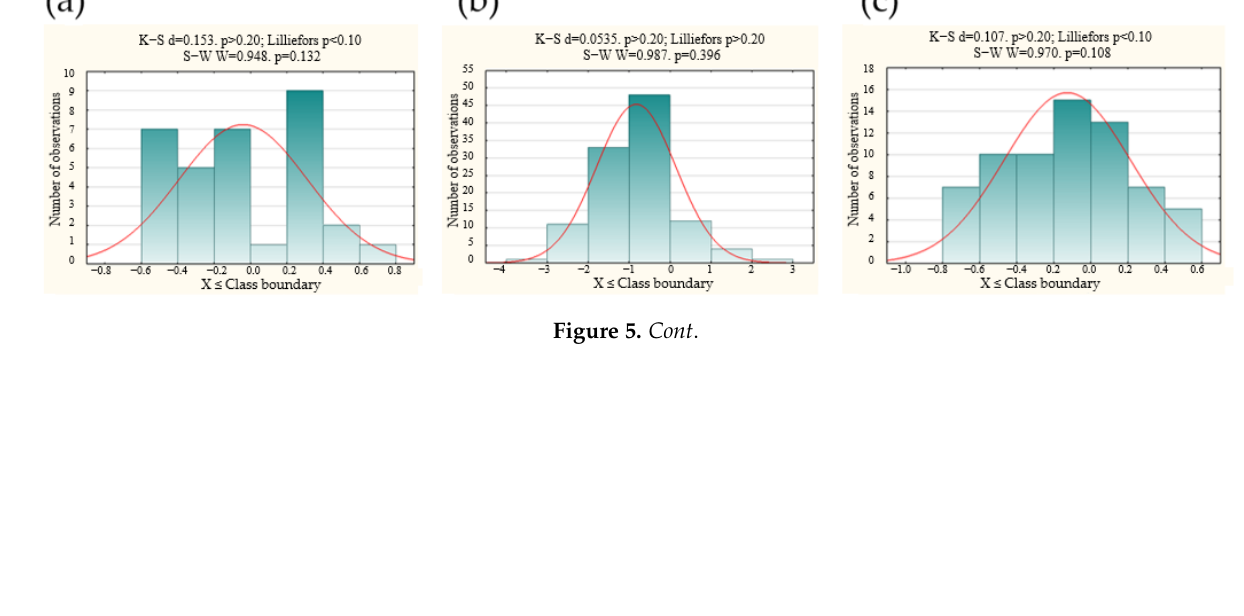
Figure 5. Histograms presenting the normal distribution of the accuracy of GPR detection (concerning three survey meth- ods) for specific test periods: ( a , b ) the 1st measurement period; ( c ) the 2nd measurement period; ( d , e ) the 3rd measurement period; ( f , g ) the 4th measurement period; ( h ) the 5th measurement period. Histograms ( a , c , d , f ) refer to method 1, ( b , e , h ) to method 2, and ( g ) — to method 3. To demonstrate the repeatability of detection of the relevant utility networks per- formed in various seasons (measurement series), let us analyse the results of the Fisher- Snedecor test. Based on Table 6, we can conclude that the hypothesis stating that variances in the corresponding populations are equal was rejected in five cases (for method 1) and in one case (for methods 2 and 3), respectively. Table 6. Table showing the results of the F. The First Method